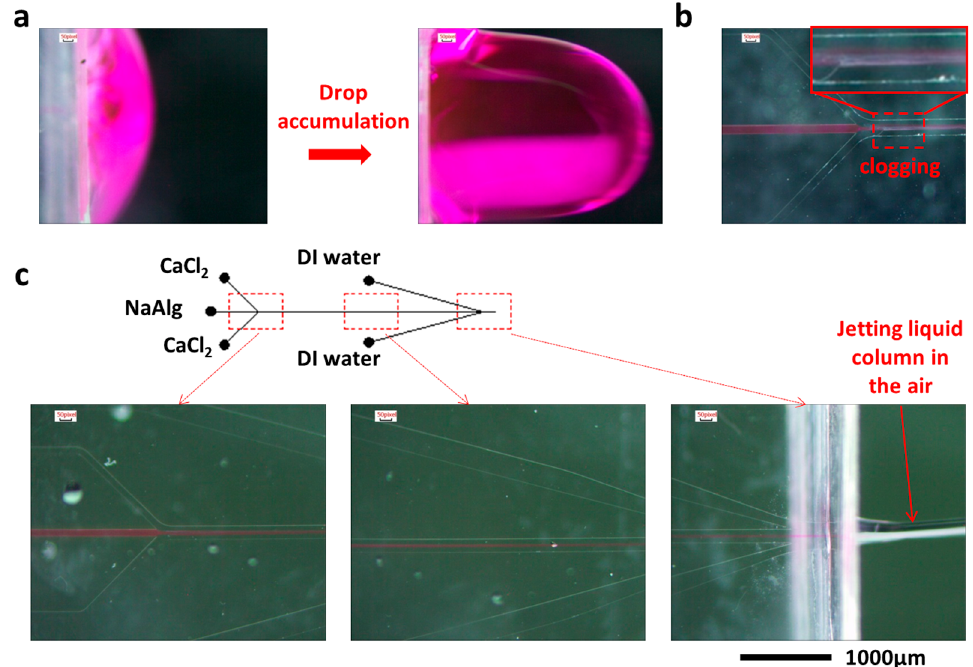
Figure 3. Microscope images of the microchannel during the microfiber fabrication. ( a ) Drop accumulation around the outlet of microchannel. ( b ) Drop occurrence interrupts the flow in the microchannel and thus causes clogging. The white floccule was the solidified alginate hydrogel which is stacked and clogged in the microchannel. ( c ) Optical images of microchannel when the microfiber consistently jetted from the outlet. DI water: Deionized water.